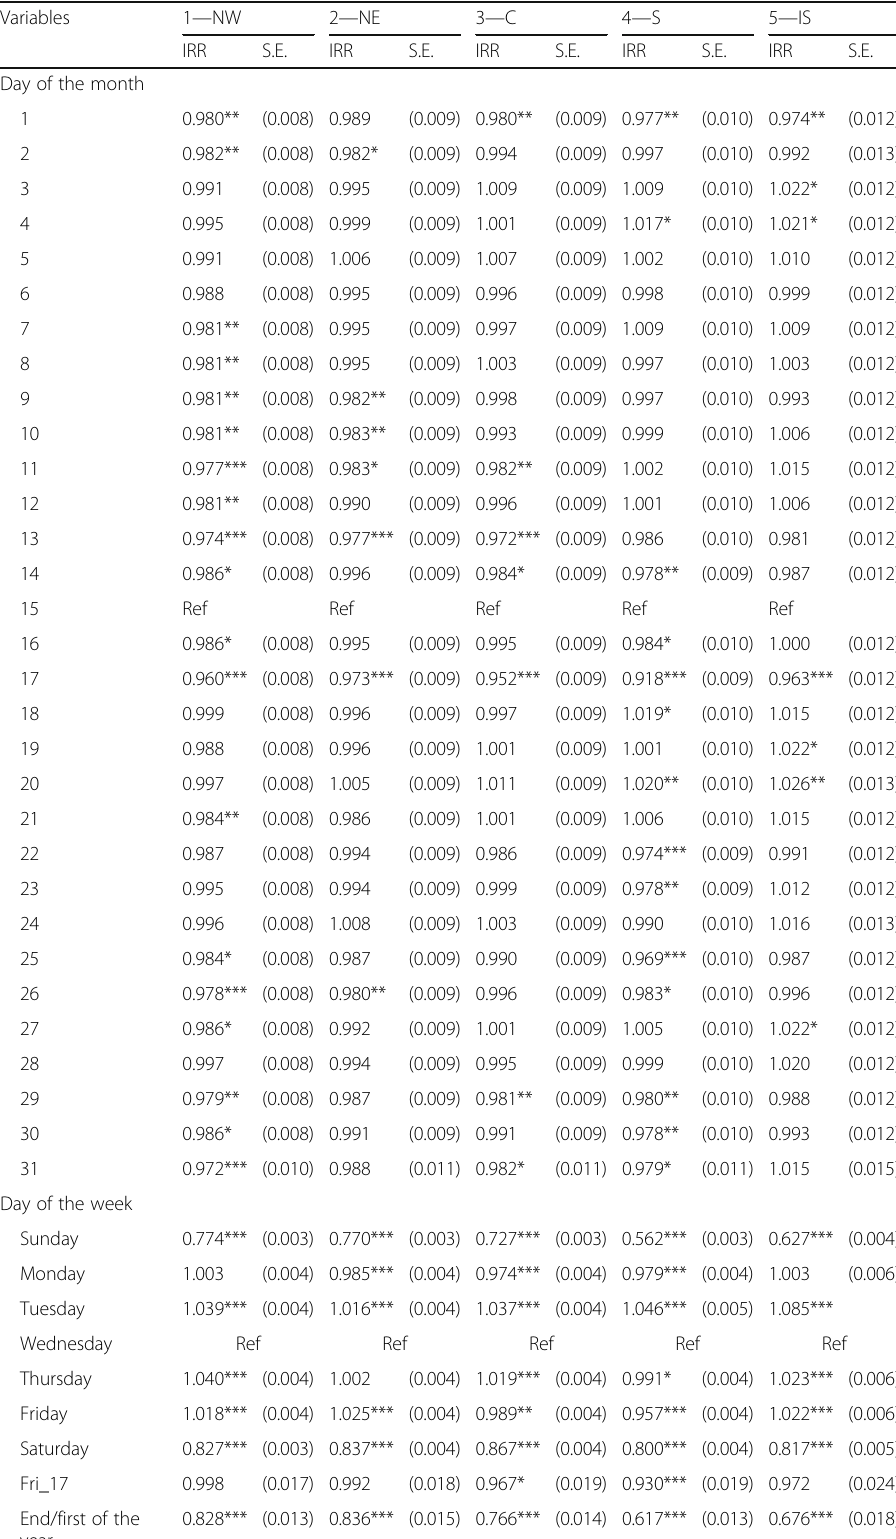
Table 2 The calendar effect on the daily male births, Italian macro-areas 1 January 1999 to 30 June 2016